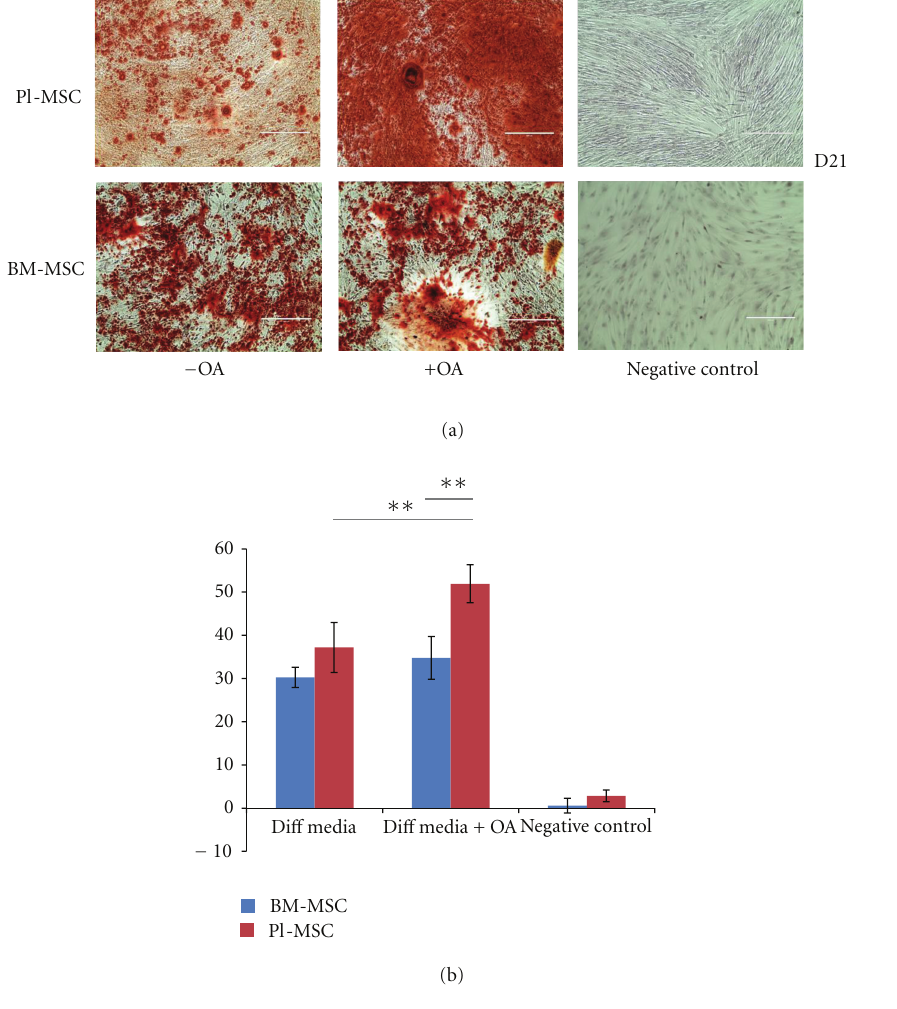
Figure 5: Osteoactivin trigger increased osteogenic di ff erentiation in human fetal and bone marrow MSCs. (a) Illustration of increased osteogenic di ff erentiation with OA compared to control (without OA) after 21 days in Mb-MSCs and BM-MSCs. (b) Quantification of osteogenic di ff erentiation with or without Osteoactivin ( ∗∗ P < 0 .